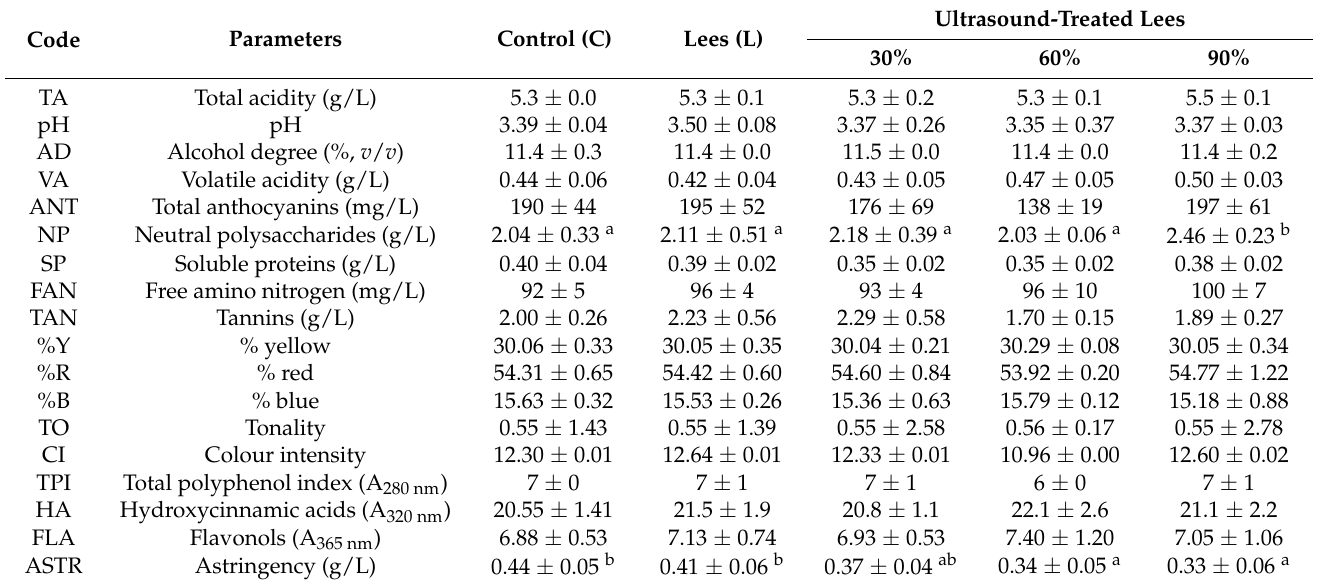
Table 1. Oenological parameters of the wines aged on ultrasound-treated and untreated lees (different letters indicate significant differences between samples ( p <